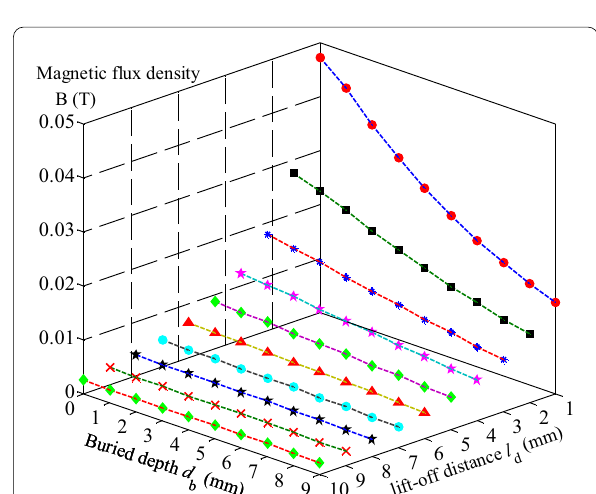
Figure 6 The B zMFL of ten inner defects at the same lift-off distance (8) l d of 1.0 mm